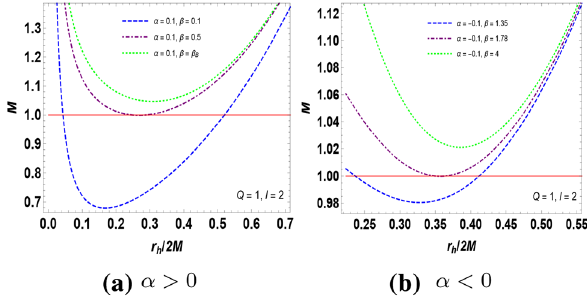
Fig. 4 The mass of the black hole for positive α ( a ) and negative α ( b